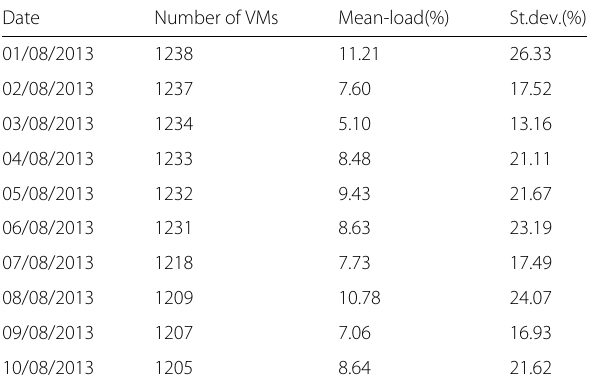
Table 3 Statistical characteristics of Bitbrains workloads